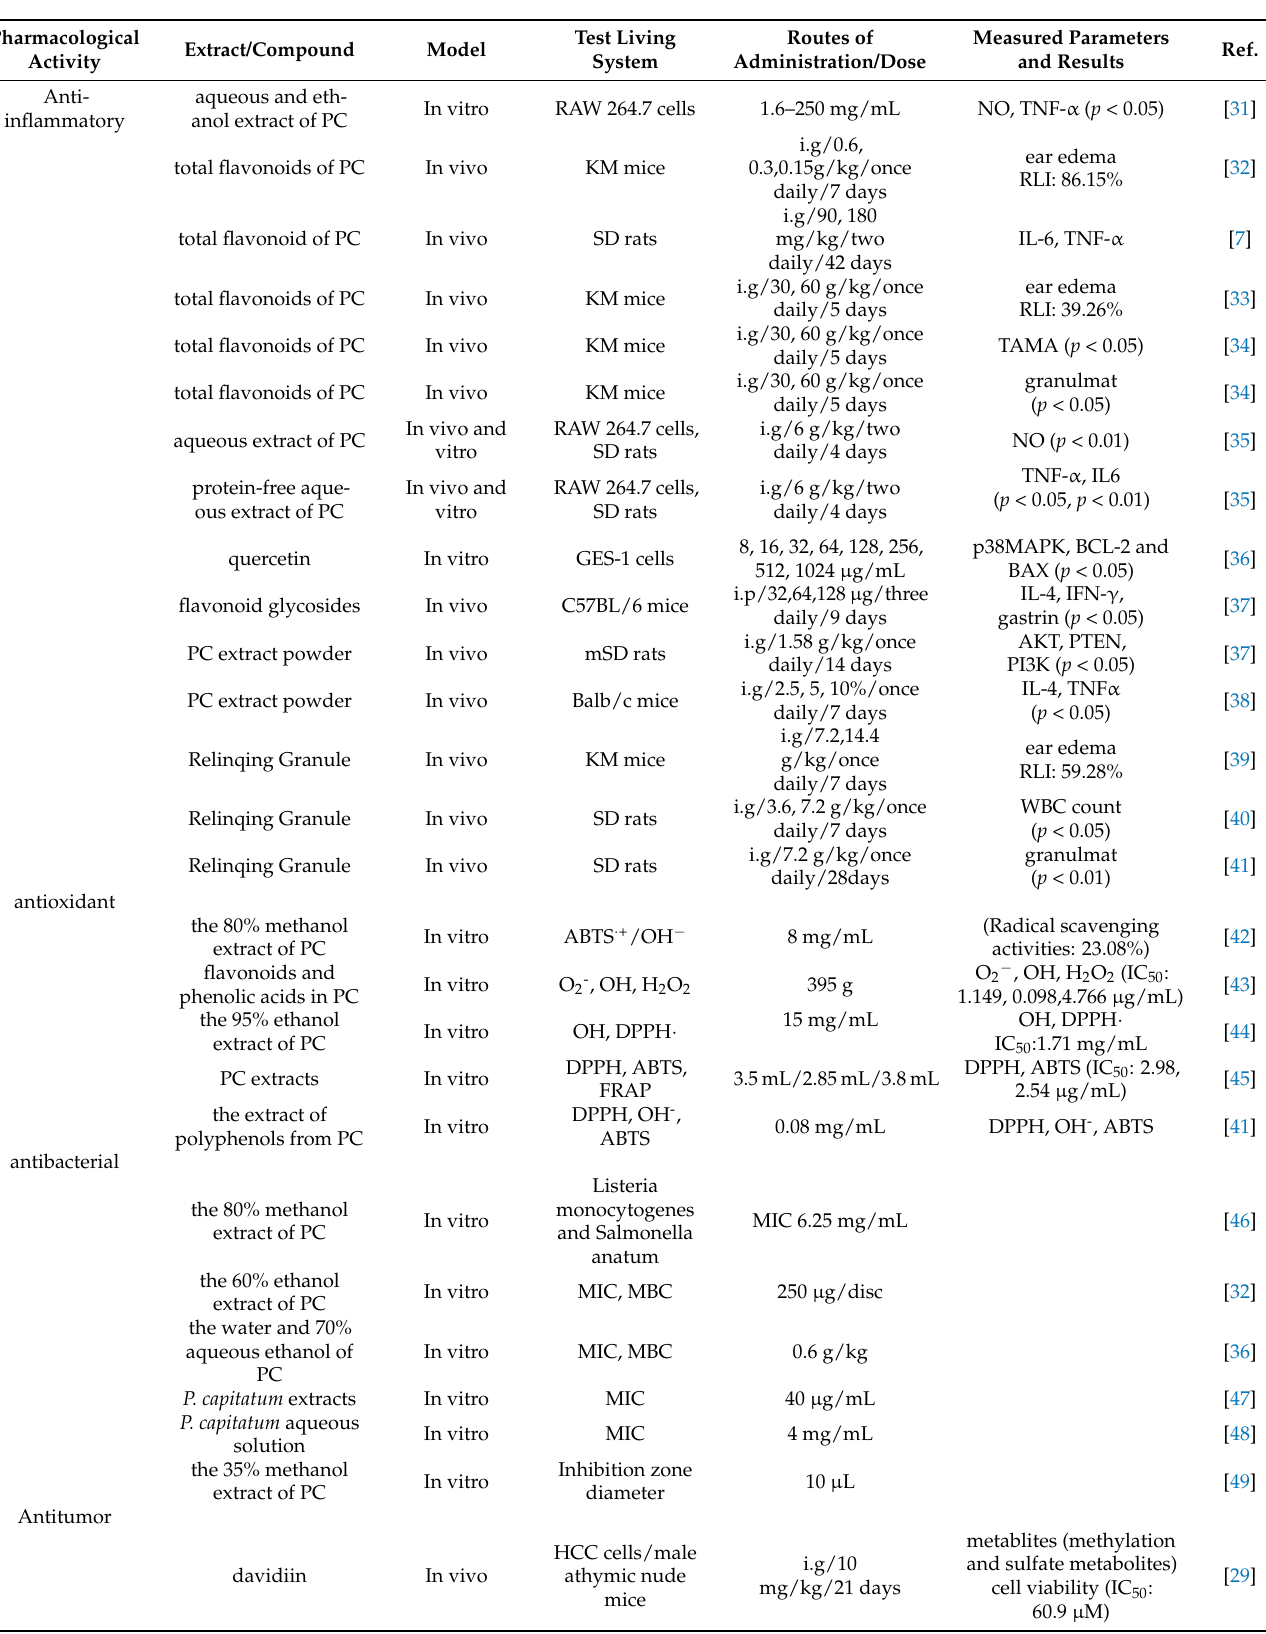
Table 1. The bioactivities of extracts and components from P. capitatum